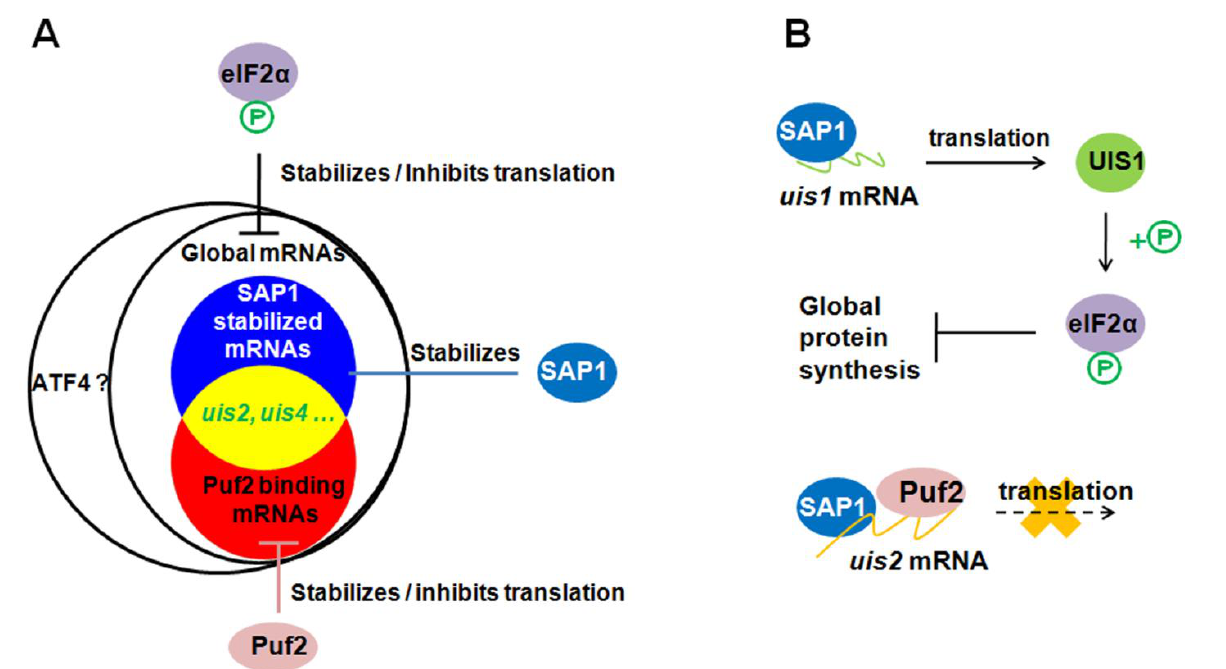
FIGURE 1: Model illustrating translational repression in malaria sporozoites. (A) Translational repression by eIF2α phosphorylation and Puf2. Puf2 stabilizes and inhibits translation of a group of mRNAs by binding to their 3' untranslated region. SAP1 stabilizes 38 uis mRNAs and non- uis mRNAs. EIF2α phosphorylation inhibits global protein synthesis.The stalled mRNAs are assembled into RNA granules. (B) Regulation of eIF2α phosphorylation. Phosphorylation of eIF2α is controlled by the kinase UIS1 and the phosphatase UIS2. uis1 and uis2 transcripts are sta- bilized by SAP1, and the translation of uis2 is repressed by Puf2. UIS1 is dominant, and causes dormancy in Plasmodium